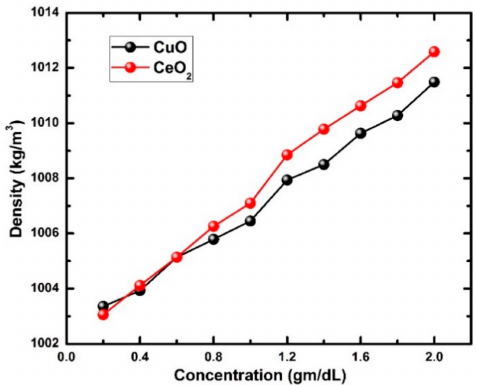
Figure 4. Variation of density with